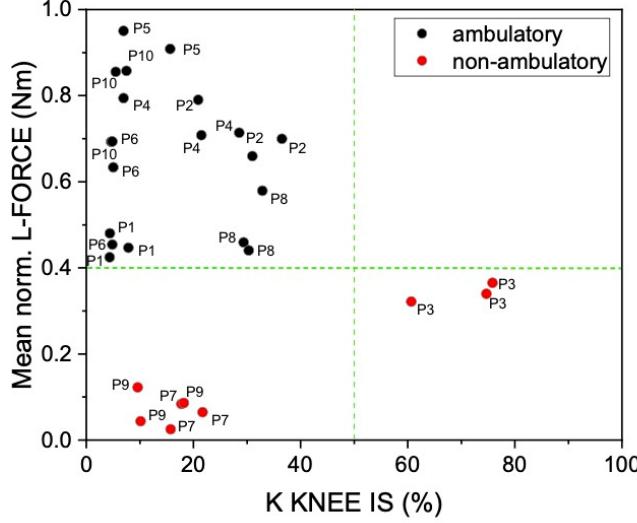
Figure 7. The knee stiffness at initial swing (K KNEE IS (%)) plotted against the mean normalized L-FORCE. For each patient, the data points of all three assessment sessions are shown. No linear relationship can be seen between the mean normalized L-FORCE measures and AGS data. Three clusters can be identified: non-ambulatory patients (red), despite all L-FORCE values being < 0.4 Nm/kg, can present with a high or low value of K KNEE IS (%). Ambulatory patients (black) show low values of K KNEE IS (%) and high values of L-FORCE.